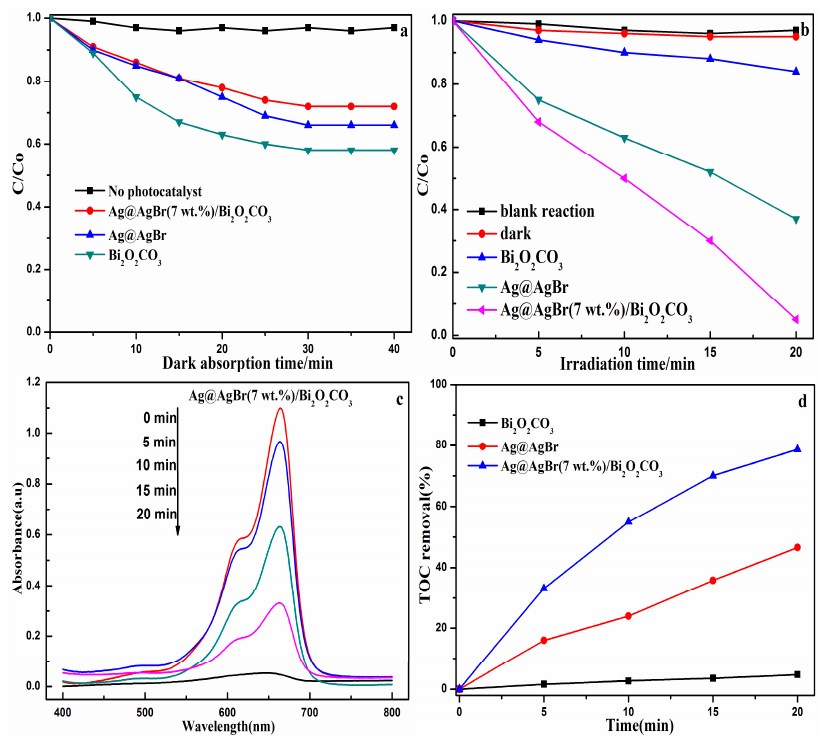
Figure 7. Photocatalytic adsorption ( a ); and degradation ( b ) curves of MB over the various samples. ( c ) Absorption spectra for MB solution in the presence of Ag@AgBr(7 wt %)/Bi 2 O 2 CO 3 under visible light irradiation over time; ( d ) TOC removal of MB over various photocatalysts under visible light irradiation.